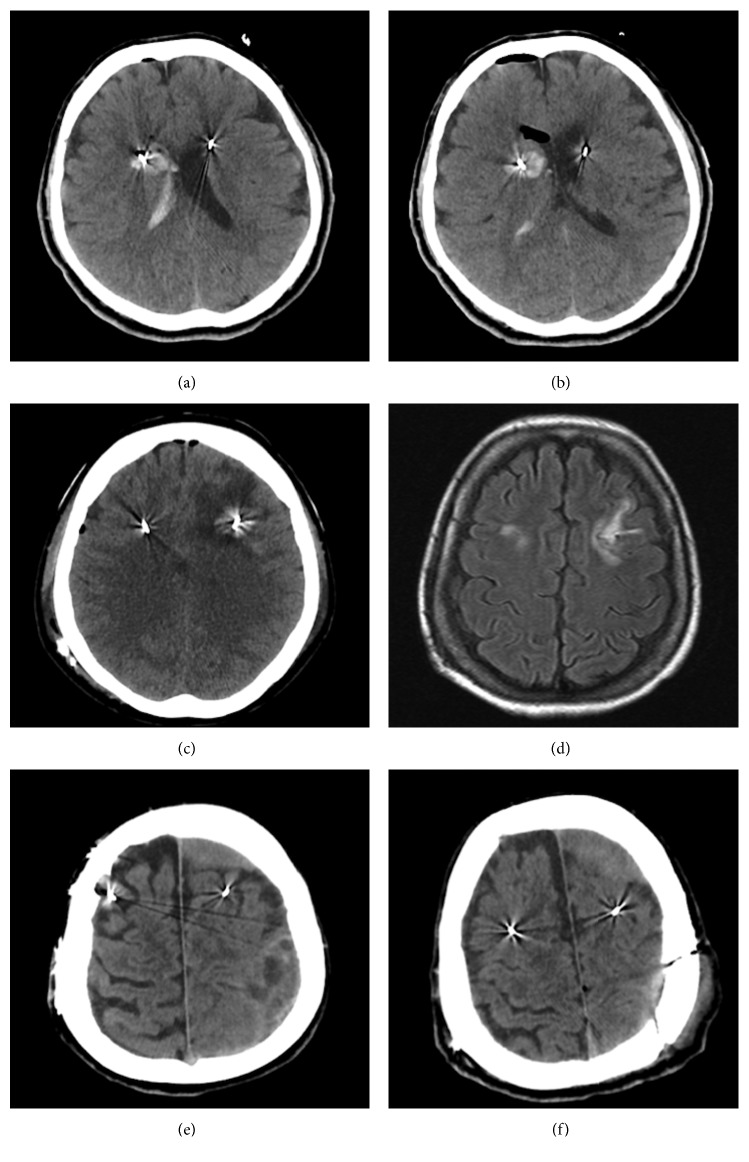
Operative complications due to deep brain stimulation surgery. (a, b) Right caudate hematoma with intraventricular hemorrhage. (c) Venous hemorrhagic infarction around the left-sided DBS lead; (d) 6-month follow-up FLAIR MRI. (e, f) Pre- and postoperative images of the left-sided chronic subdural hematoma over the parietal cortex. Note that the frontal component of the cSDH was left intact to avoid iatrogenic injury to the lead.